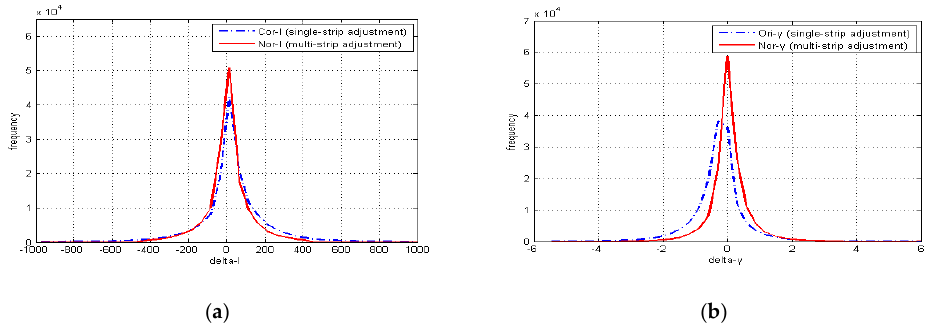
Figure 12. Histogram of delta intensity and delta backscattering coefficient in overlapped area: ( a ) delta intensity before and after multi-strip normalization; and ( b ) delta backscattering coefficient before and after normalization.